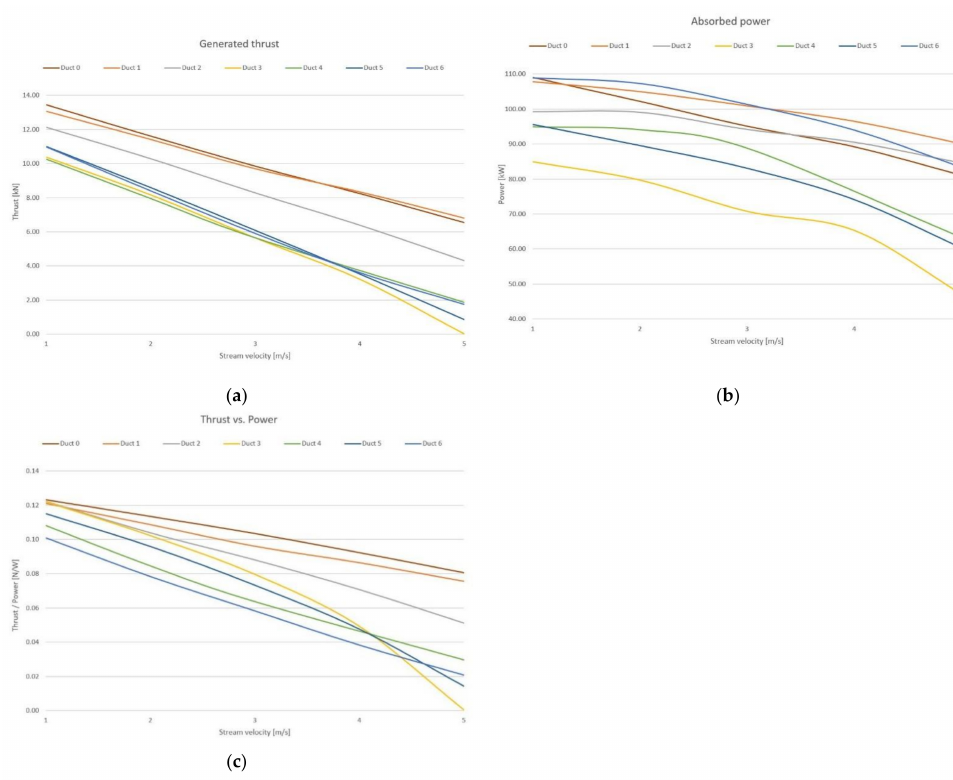
Figure 6. Comparison of the main performance characteristics of propulsors. ( a ) Generated thrust depending on flow rate; ( b ) power absorbed depending on flow rate; ( c ) generated thrust per unit of absorbed